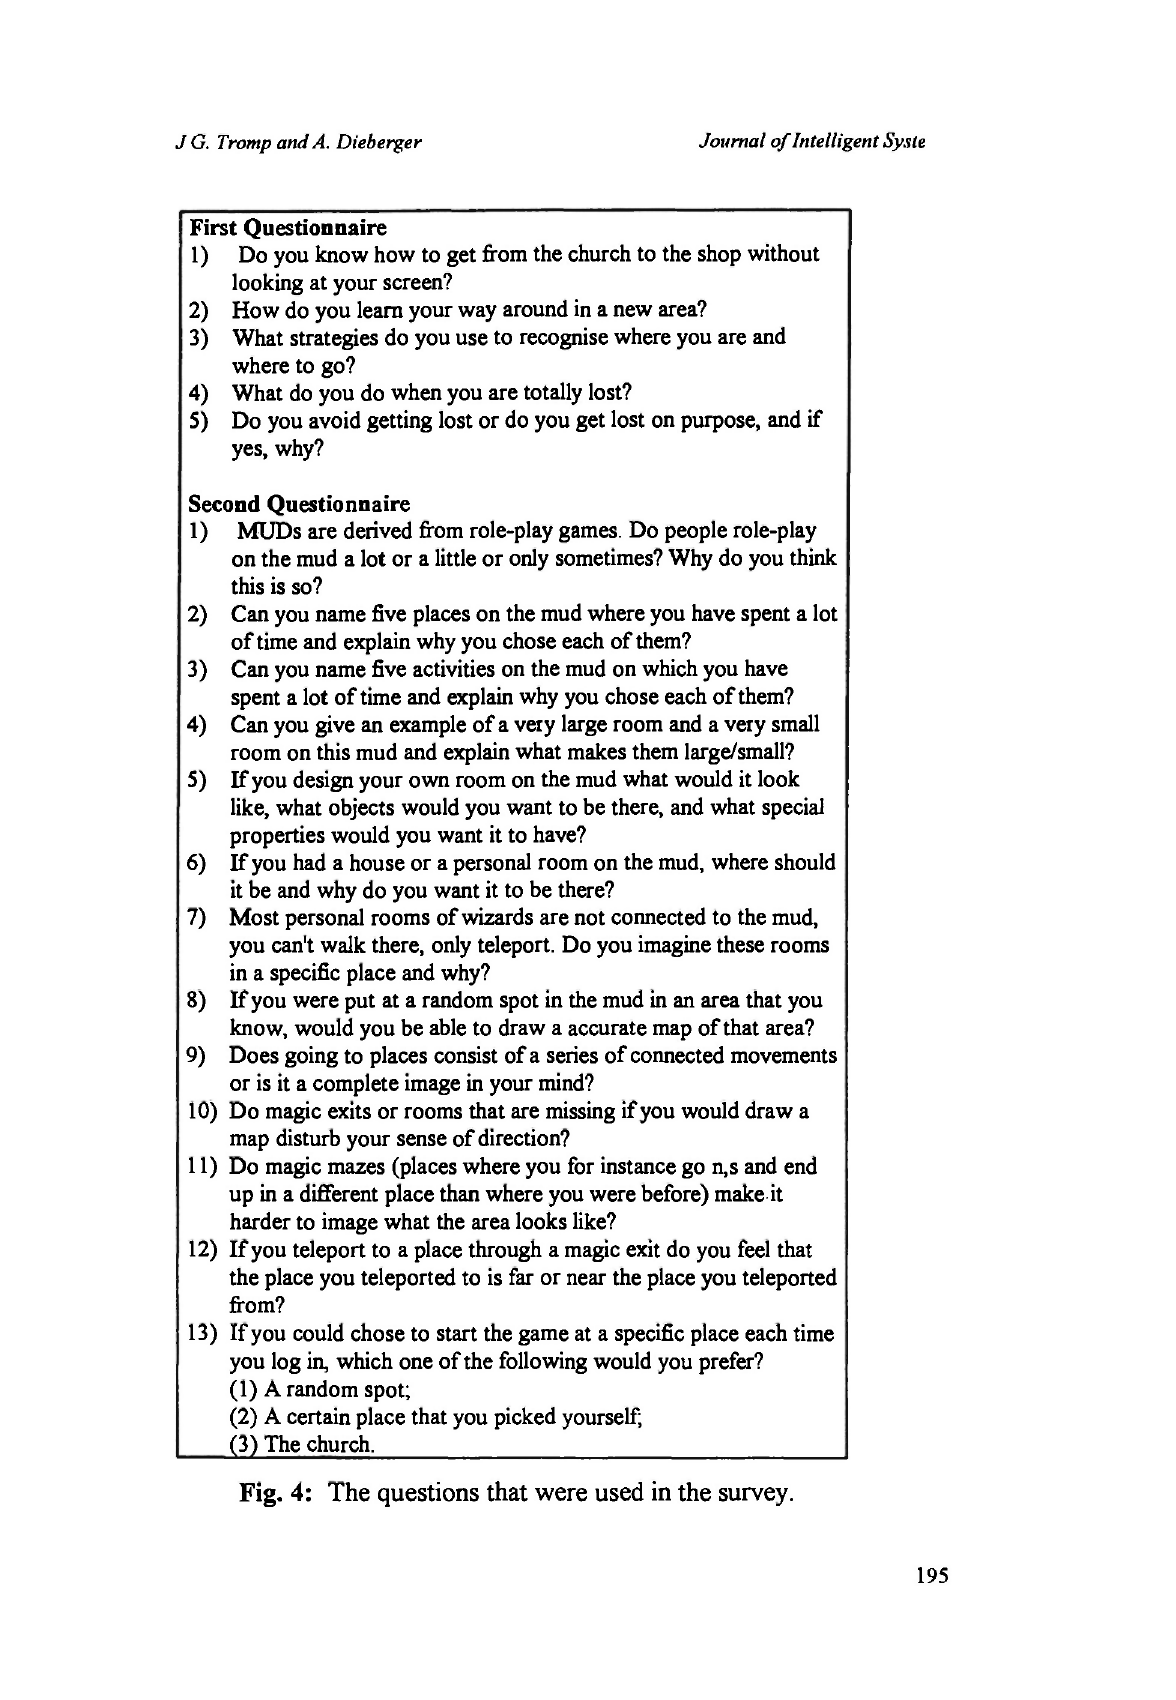
Fig. 4: The questions that were used in the